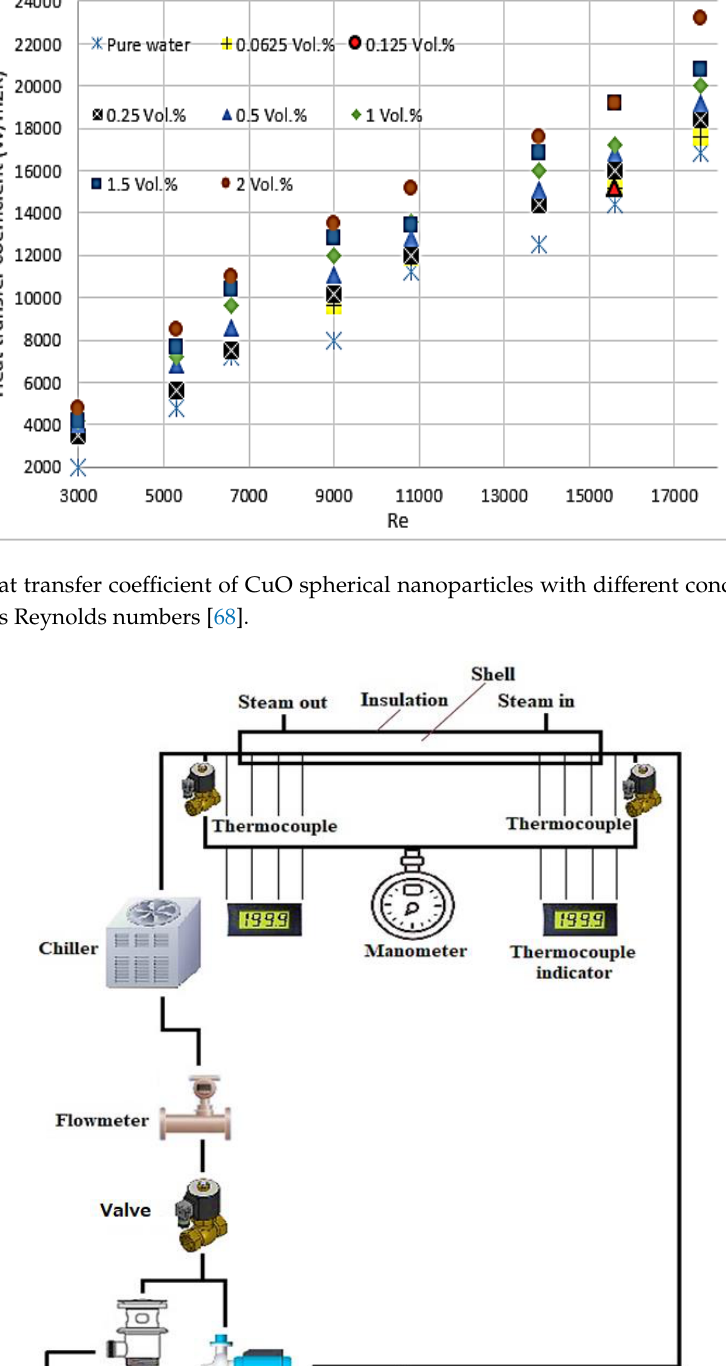
Figure 2. Heat transfer rate (Q) of CuO rectangular nanoparticles with different concentrations in water versus volume flow rate ( V ̇ ). [66]